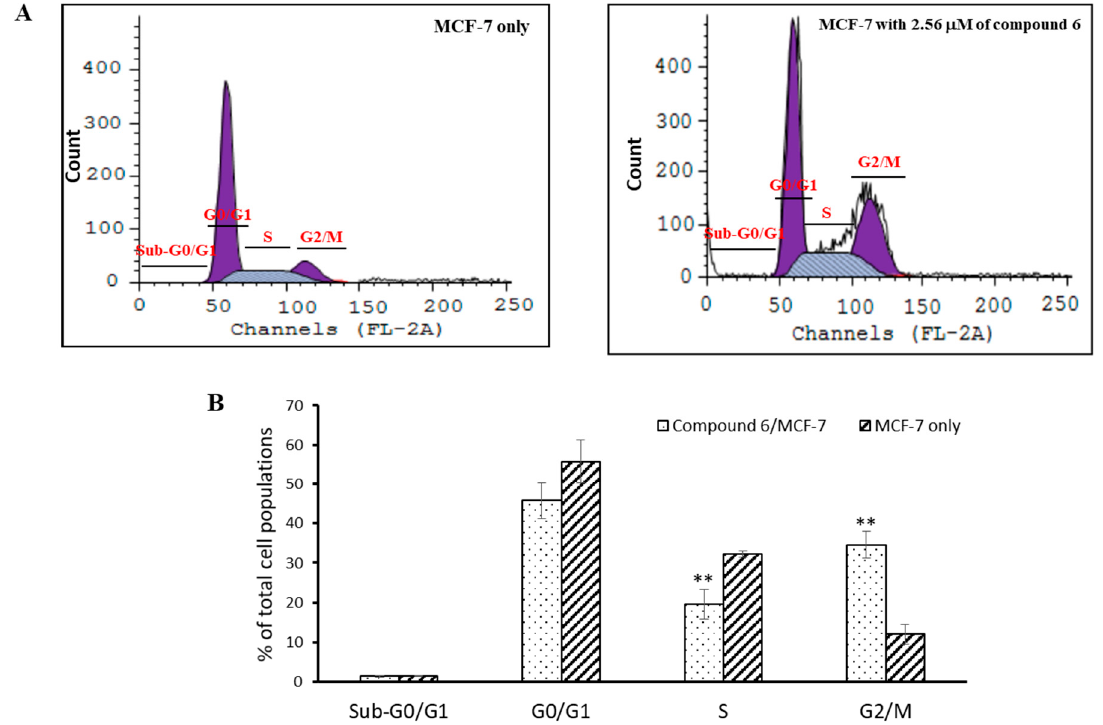
Figure 2. The effect of compound 6 at the concentration of 2.56 µ M on the MCF-7 cell cycle progression. ( A ) Representative flow cytometry data of the cell cycle change. ( B ) Percentage of the total cell populations at each cell cycle phase in each cell. ** p ˂ 0.01 according to Tukey’s test.